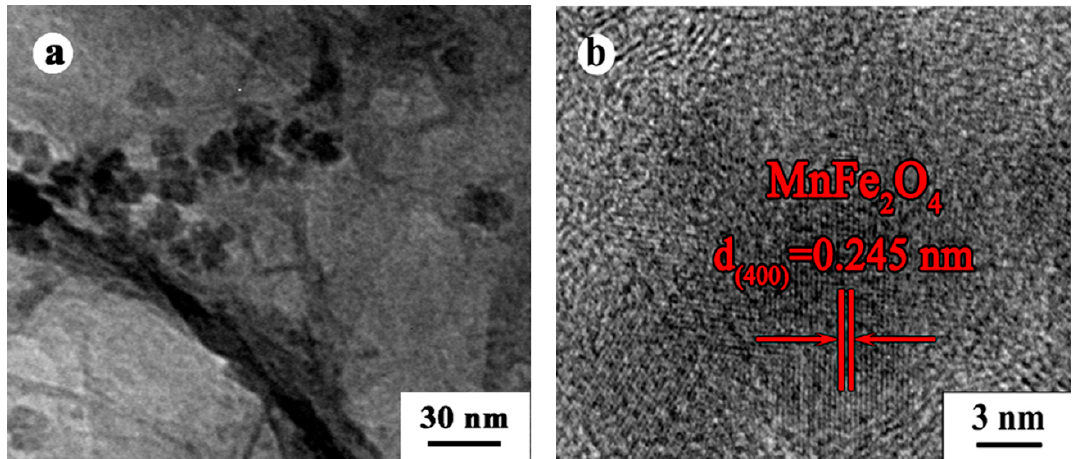
Figure 2. ( a ) TEM and ( b ) HRTEM images of the MnFe 2 O 4 /BGA composite.